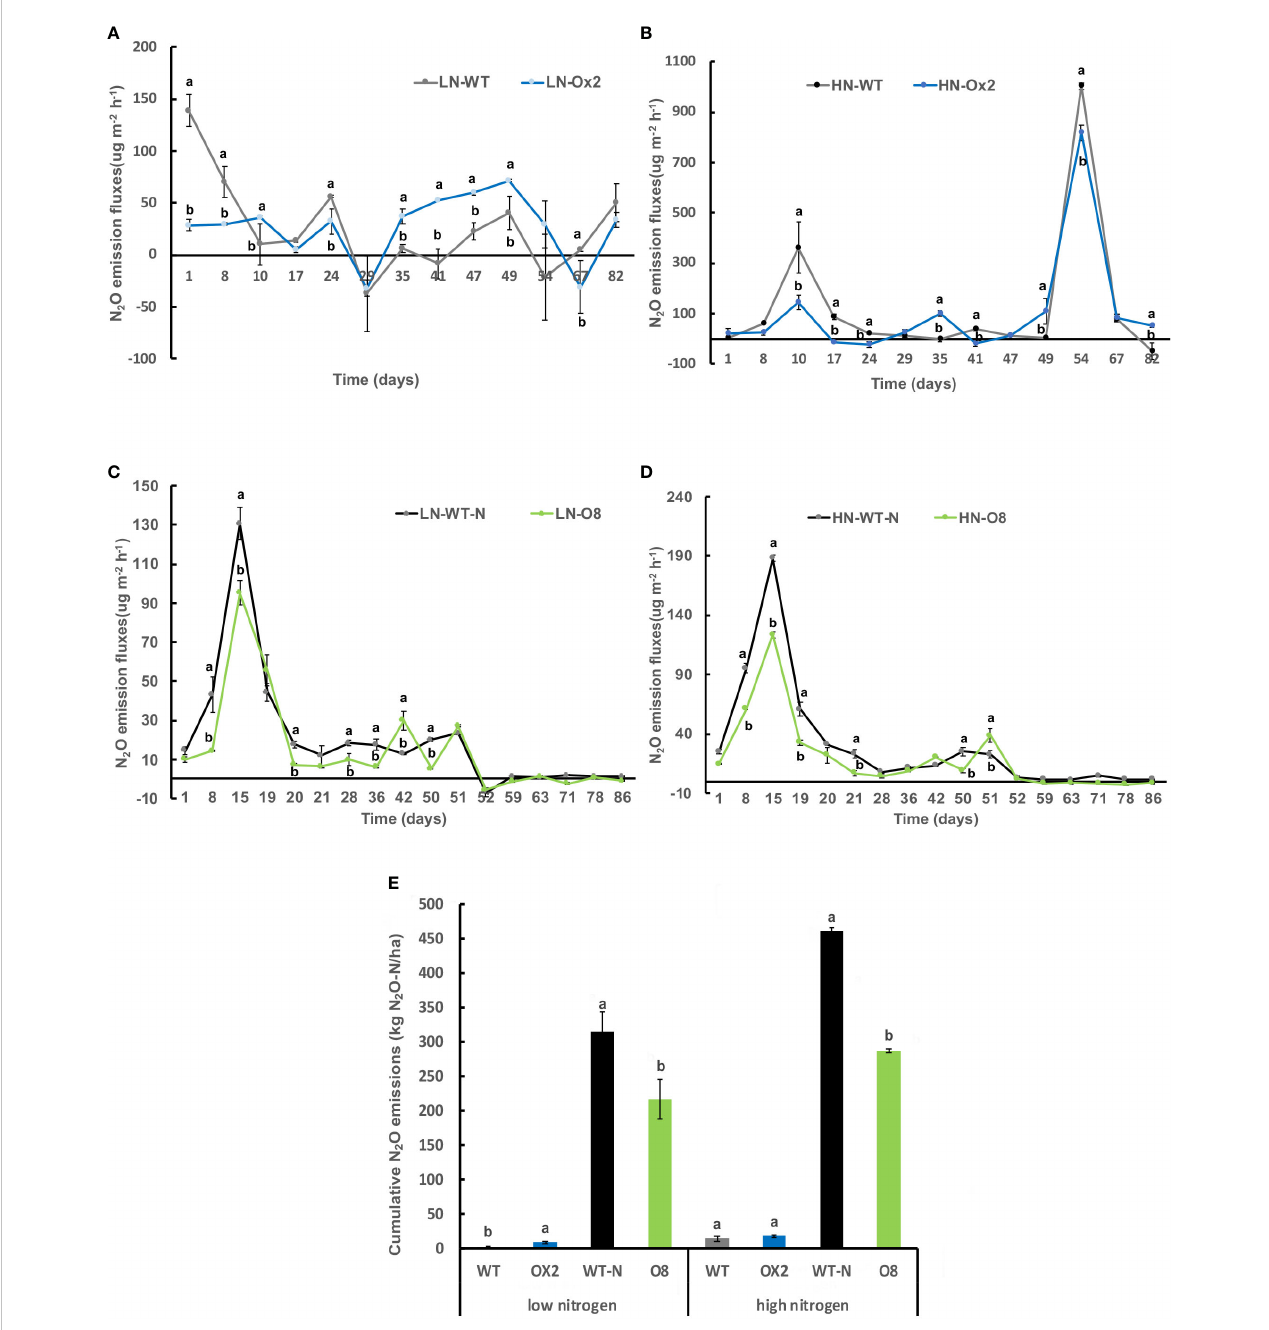
FIGURE 2 Detailed N 2 O gas emission fl uxes (ugm -2 h -1 ) from rhizosphere of WT, Ox2, WT-N and O8. The (LN) low nitrogen soil application shows in fi gure (A, C) and (HN) high nitrogen soil application shows in fi gure (B, D) . X-axis shows N 2 O gas emission recording time (days), from the fi rst measurement after transplanting seedlings from nursery to fi eld is day1 to onwards (A-D) . N 2 O emission fl ux (ugm -2 h -1 ) from the rhizosphere was compared between Ox2 in fi gures (A, B) and O8 in fi gure (C, D) with their respective wildtypes (WT) separately. Figure (E) shows cumulative N N 2 O-N/ha). Cumulative emission data consist of 13 individual values taken during various growth stages (n=13). Error bars: SE (n = 3 Signi fi cant difference between two cultivars (transgenic and respective WT) are indicated by different letters: a= high value, b= lower value ( t -test, p<